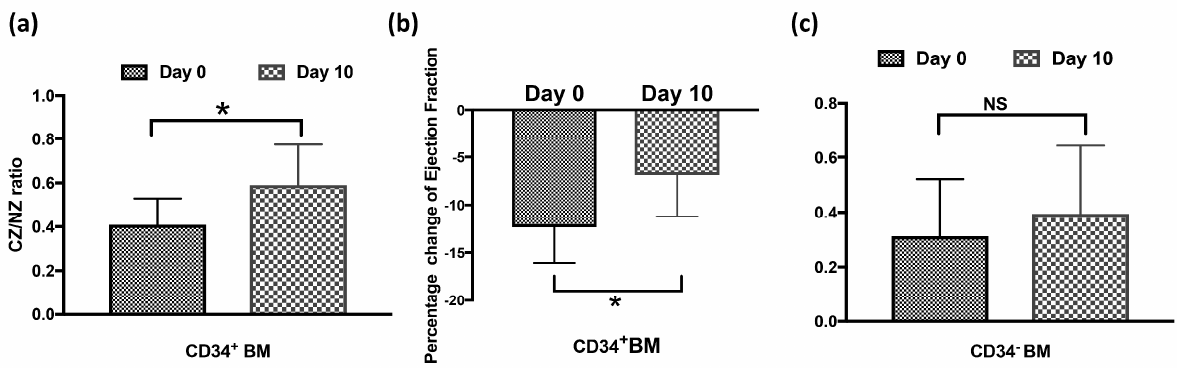
Figure 8. Confocal images of immunostaining of collateral dependent zone (CZ) of GFP + CD34 + BMT recipient rat heart after 10 days’ repetitive ischemia (RI). ( a ) GFP + CD34 + BMSCs colocalized with endothelial cell (EC) marker isolectin-B4 (as shown by arrows), indicating that GFP + CD34 + BMSCs differentiated into EC during coronary collateral growth (CCG) induced by RI. ( b ) and ( c ). GFP + CD34 + BMSCs colocalized with EdU (as shown by arrows), suggesting that GFP + CD34 + BMSCs proliferated during CCG. The scale bar equals 10 µm.